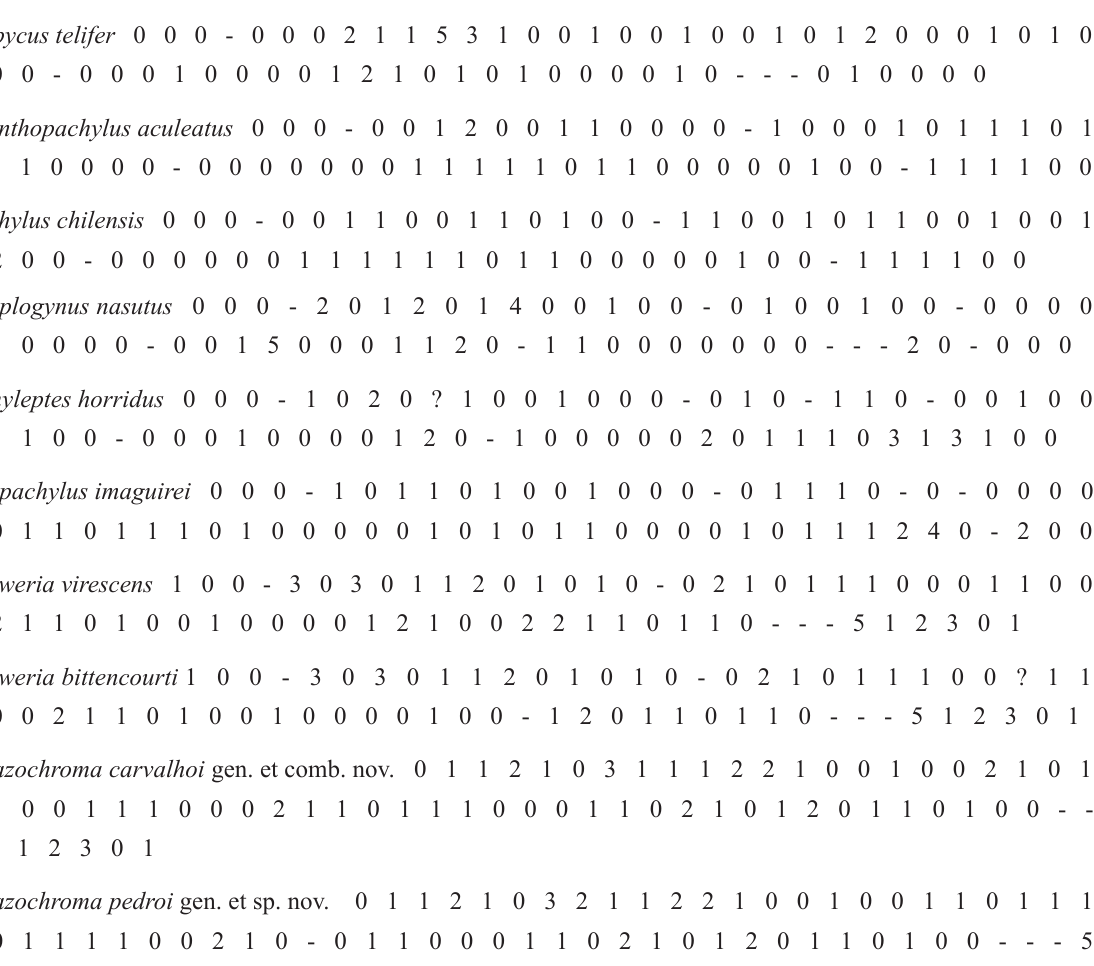
Table 2. Matrix of character states for the cladistic analysis of the